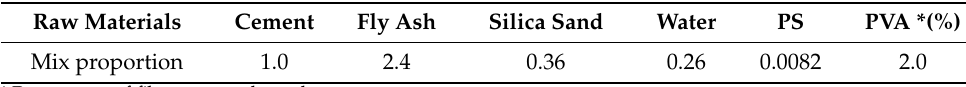
Table 1. Mixture weight proportion of the ECC specimens. Raw Materials Cement